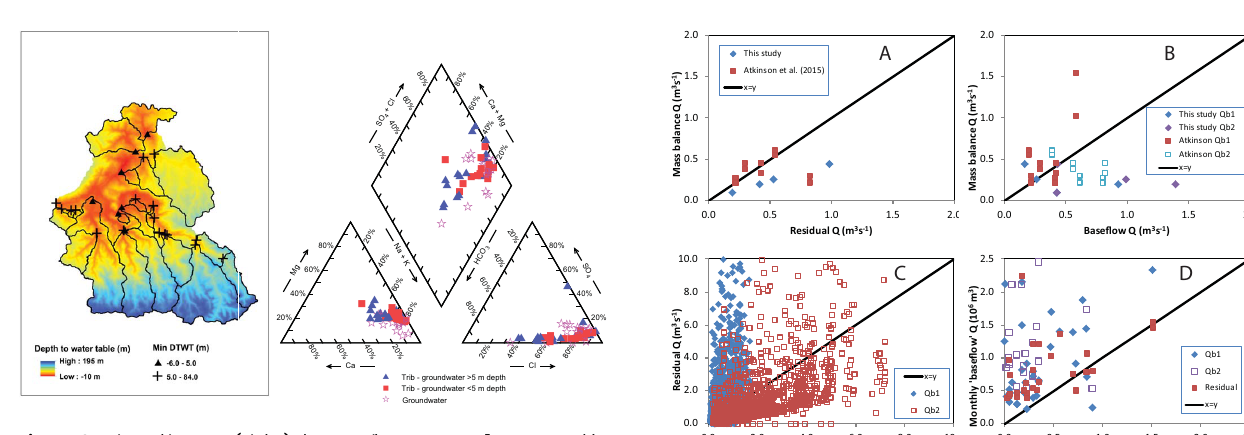
Figure 8. Piper diagram (right) shows tributary samples grouped by the minimum depth to groundwater table in the sub-catchment up- stream of the sampling point. Compositions of sampled groundwa- ter bores are also shown. The spatial location and sub-catchment ex- tent are shown superimposed on the potentiometric depth to ground- water map for September 2010.